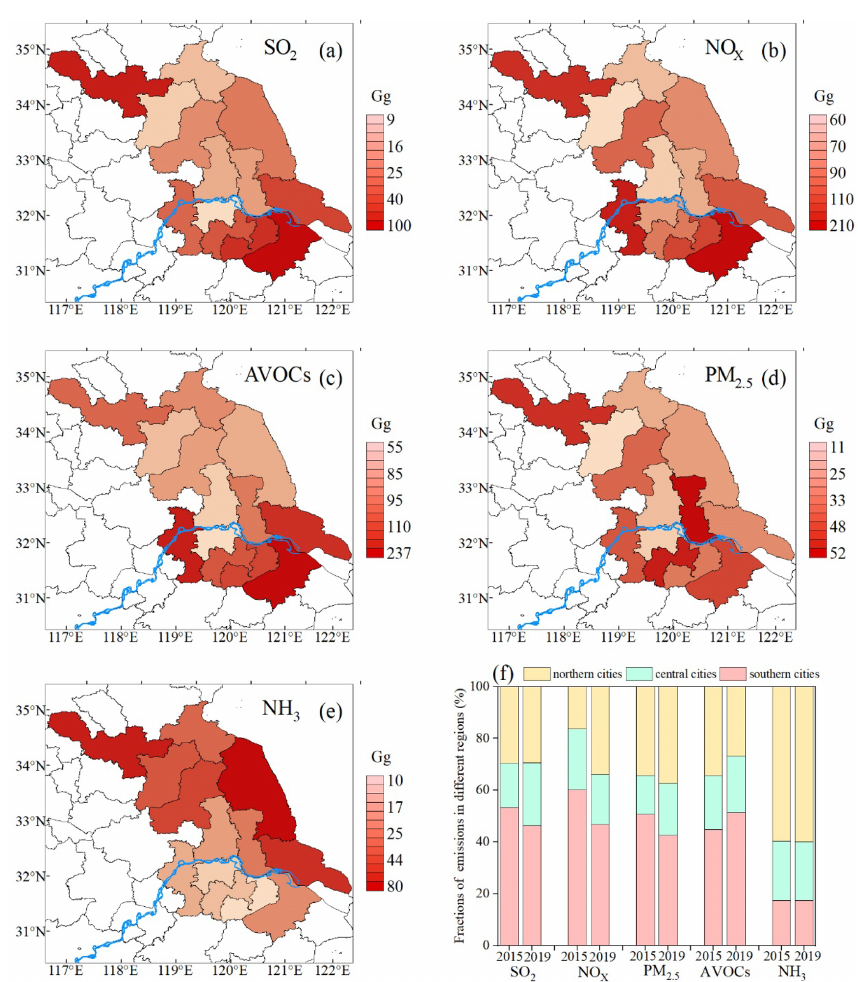
Figure 4. The city-level emissions and spatial distribution include (a) SO 2 , (b) NO x , (c) AVOCs, (d) PM 2 . 5 , and (e) NH 3 . Panel (f) shows the proportions of emission by different regions for 2015 and 2019. The blue line indicates the Yangtze River. The map data provided by Resource and Environment Data Cloud Platform are freely available for academic use (http://www.resdc.cn/data.aspx?DATAID=201, last access: 10 October 2022), © Institute of Geographic Sciences & Natural Resources Research, Chinese Academy of